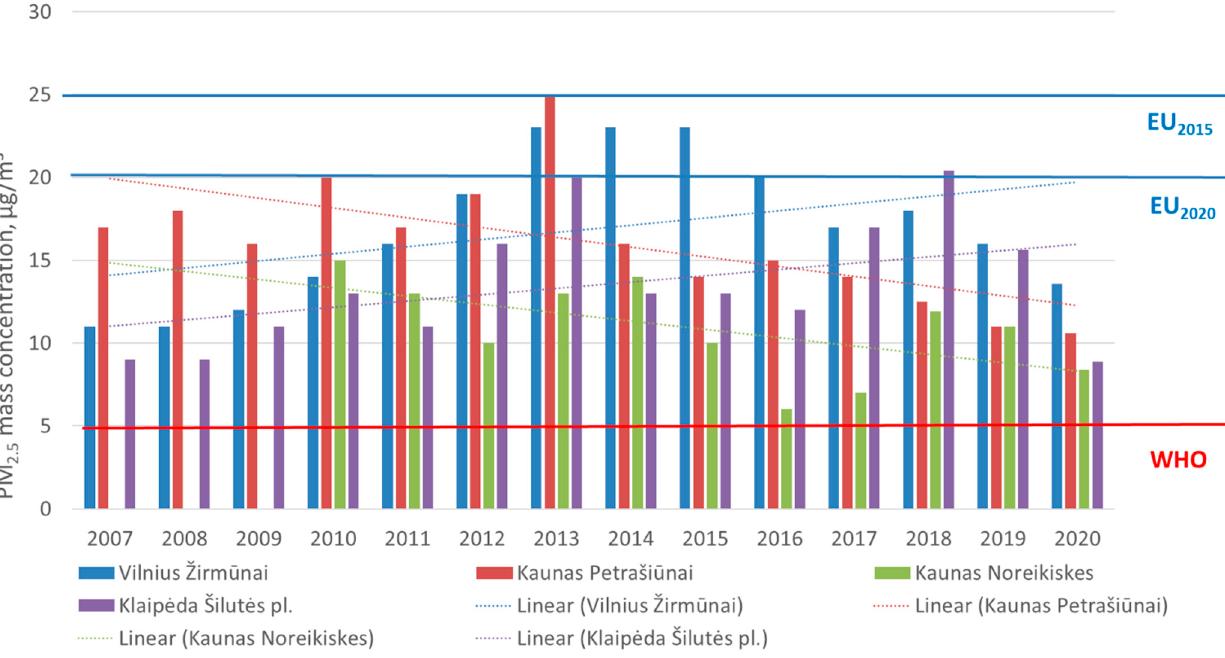
Figure 8. Annual mean PM 2.5 concentration and trends in biggest cities.